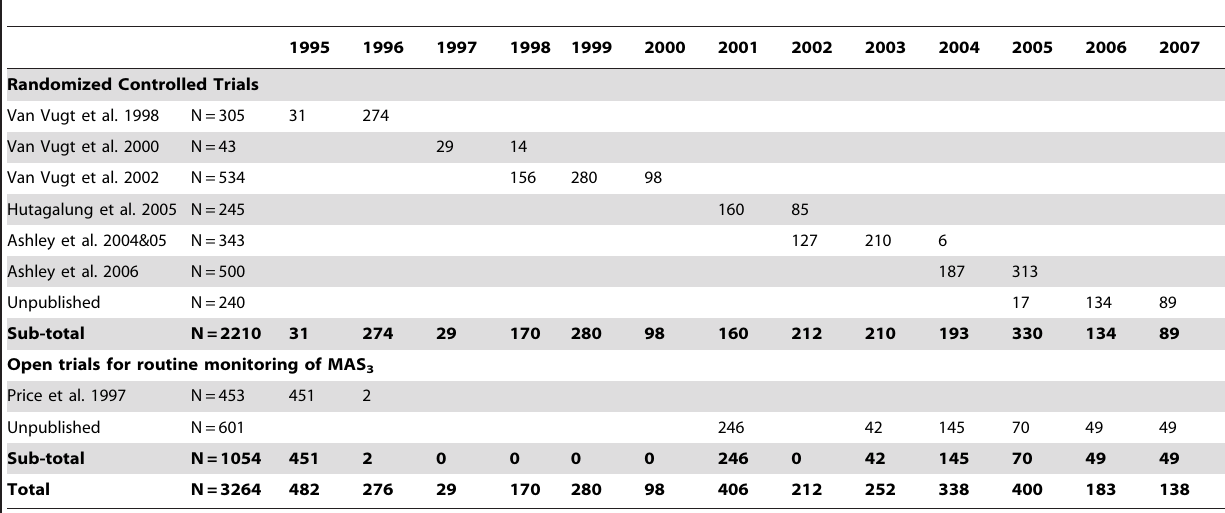
Table 1. Patients enrolled in antimalarial drug efficacy trials who received MAS 3 , between 1995 and 2007, on the northwestern border of Thailand.